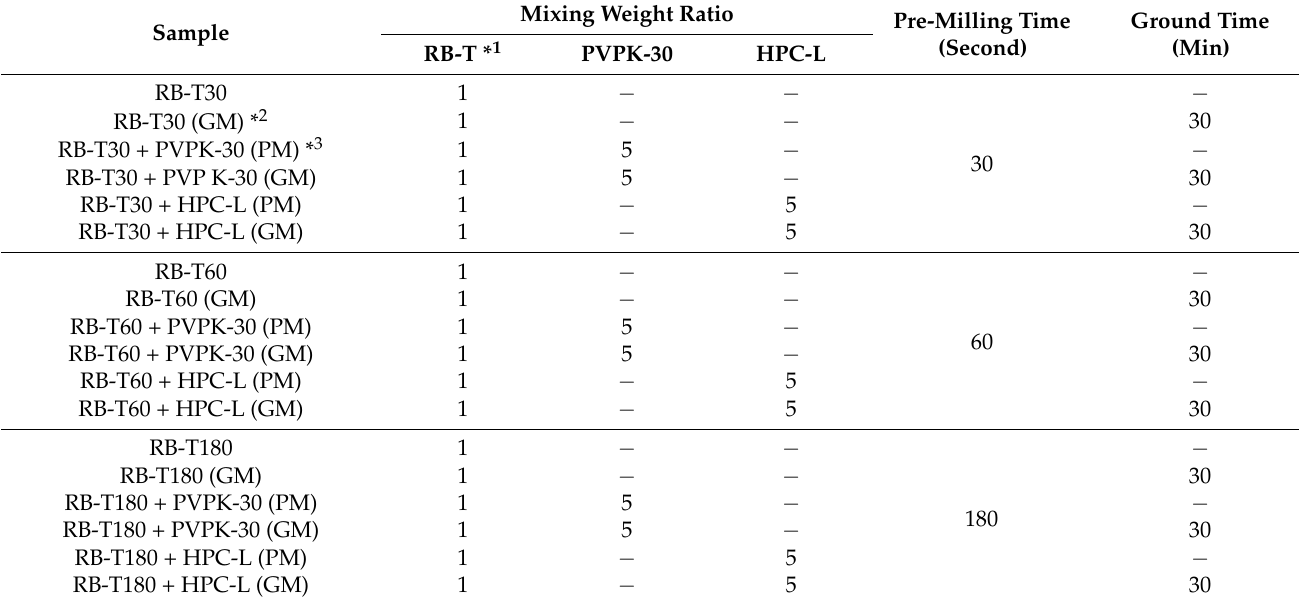
Table 1. Formulations of various